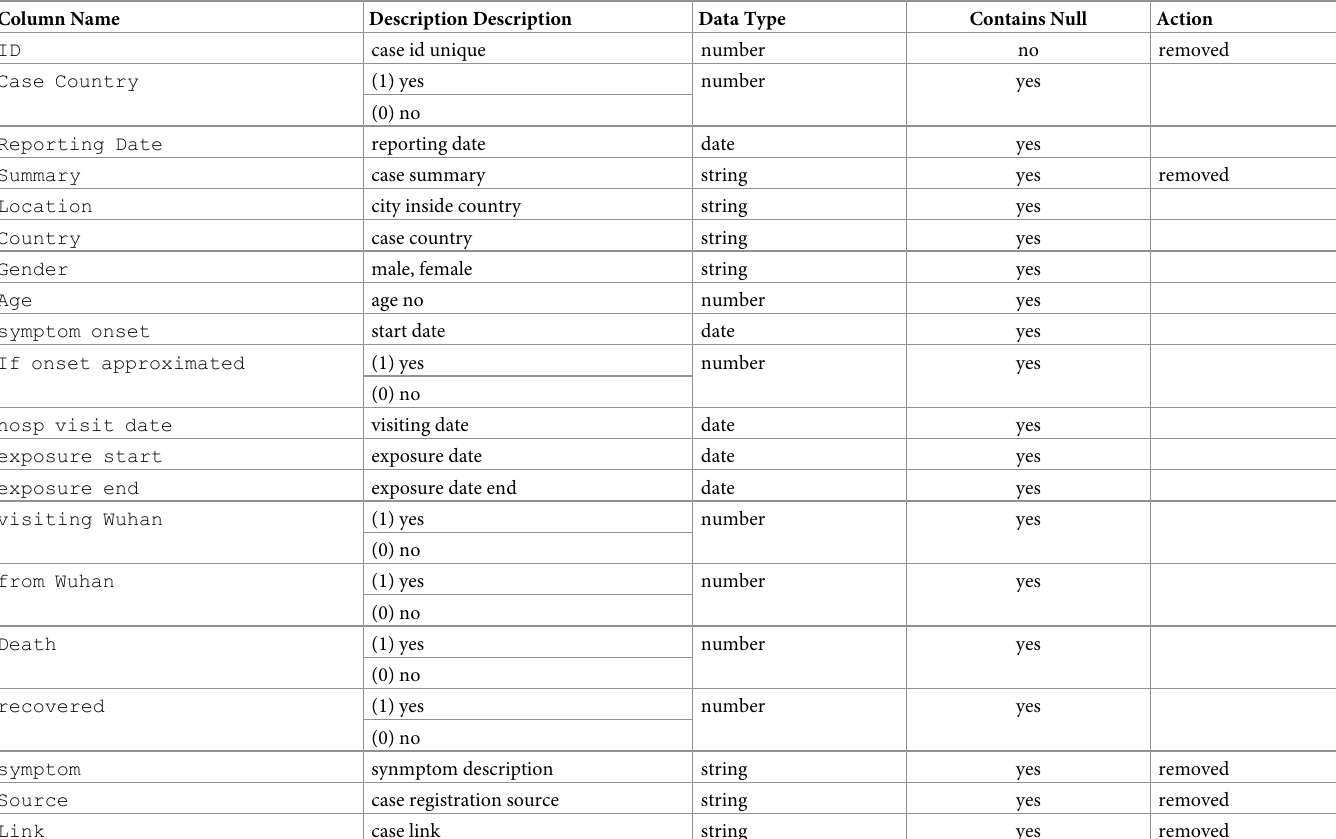
Table 5. Patients descriptive datasets contains COVID-19 infected cases which reported in Wuhan